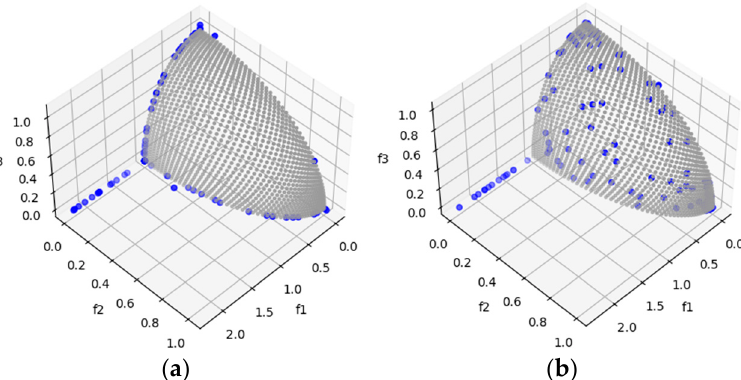
Figure 5. The plots of the approximate PFs with the highest HV value against real PF. ( a ) DTLZ4 approximate PF using MOSA/D-CGO; ( b ) DTLZ4 approximate PF using MOSA/D-DE. DTLZ5 is a test problem derived from DTLZ2 that allows us to observe whether the